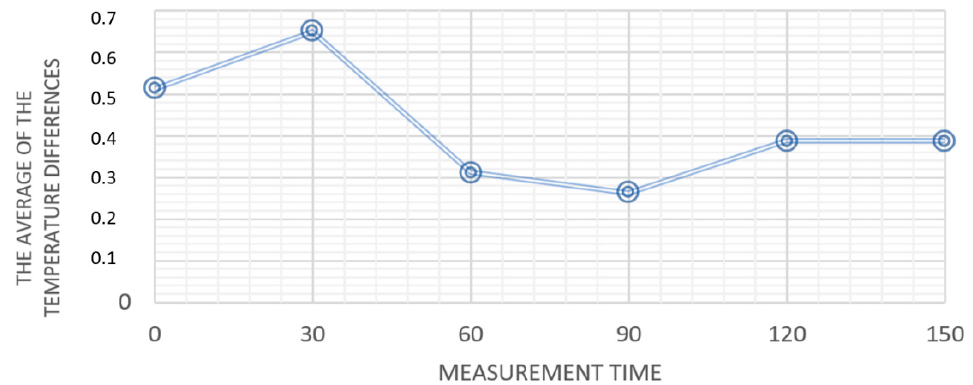
Figure 3. Mean temperature differences in the periapical regions of the suspect and contralateral teeth obtained for all patients, with the time of measurement during the patient keeping mouth